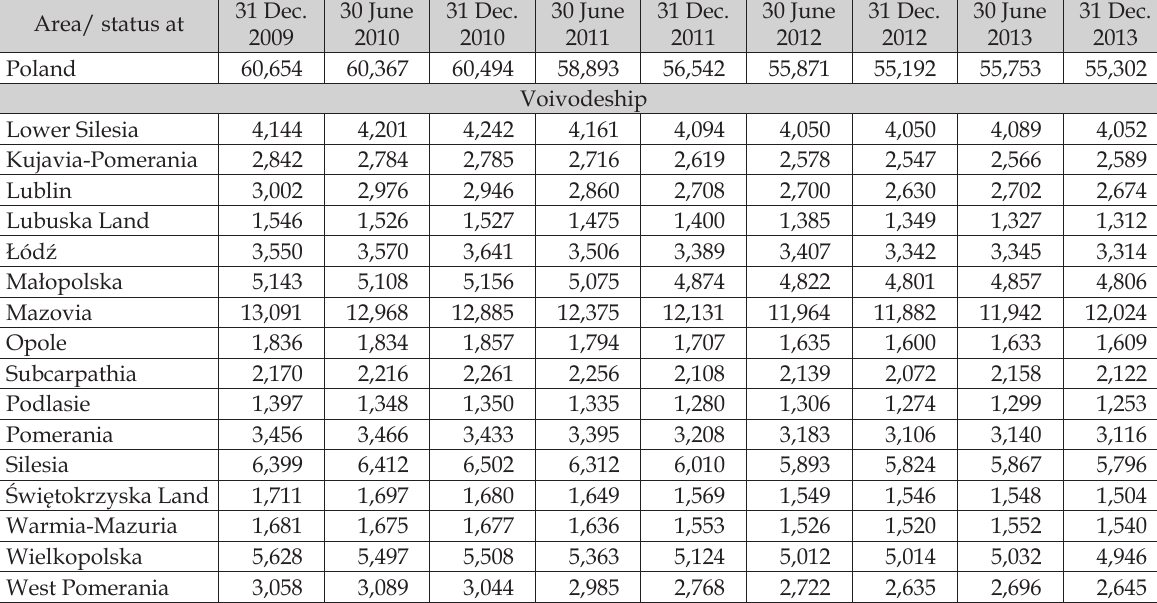
Table 4. Number of entities of the sub-sector of arts and crafts within the creative sector entered into the REGON register in the years